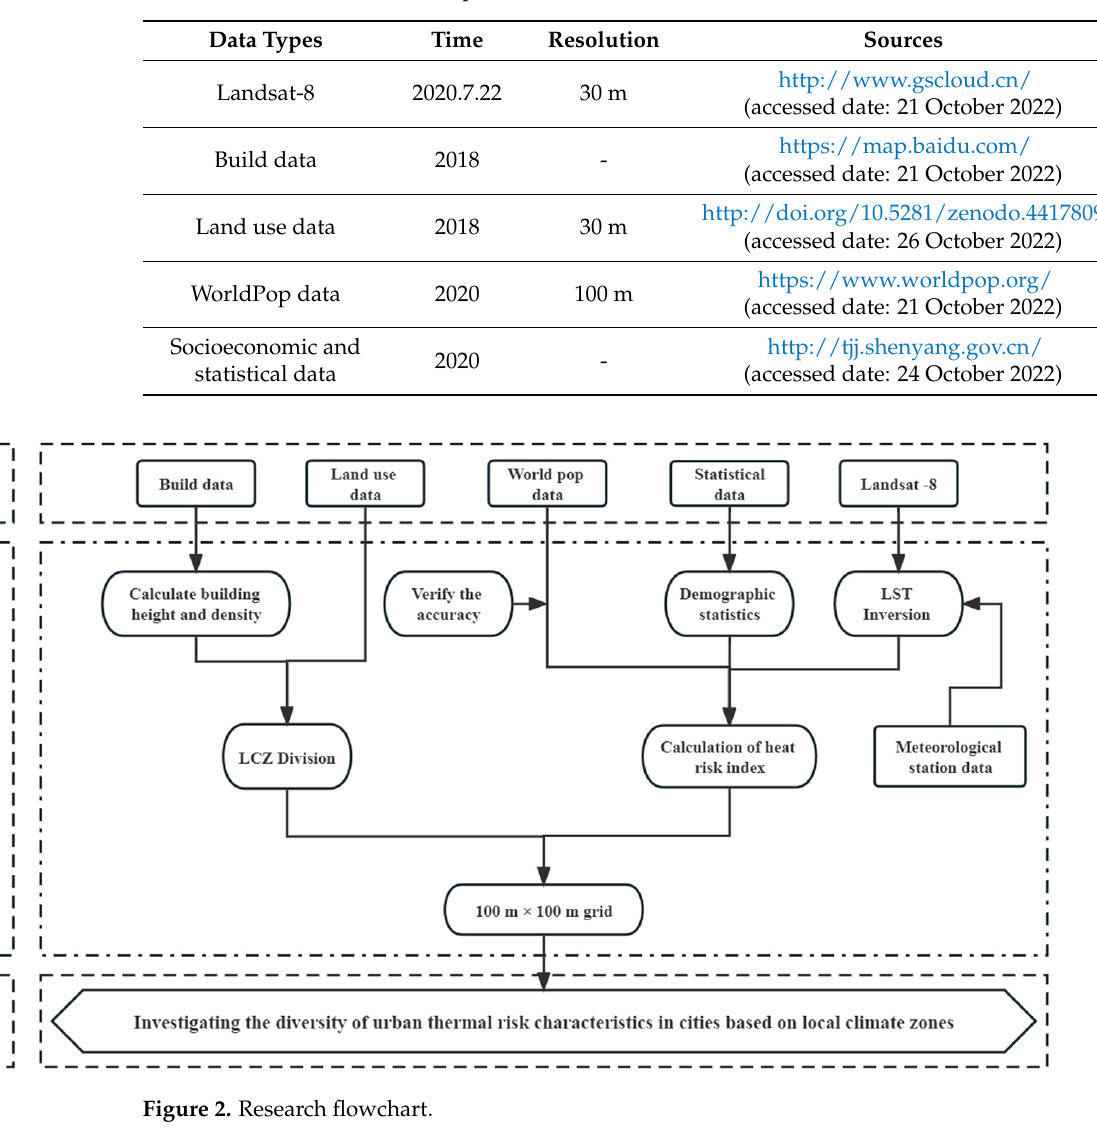
Table 1. Data sources and description.